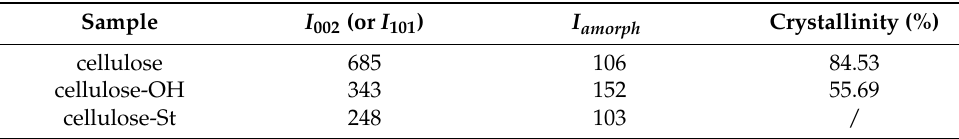
Table 1. The crystallinity of cellulose, cellulose-OH, and cellulose-St.